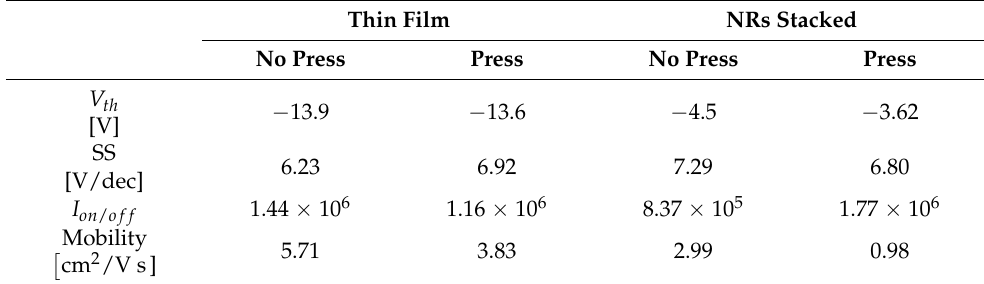
Table 5. TFT parameter